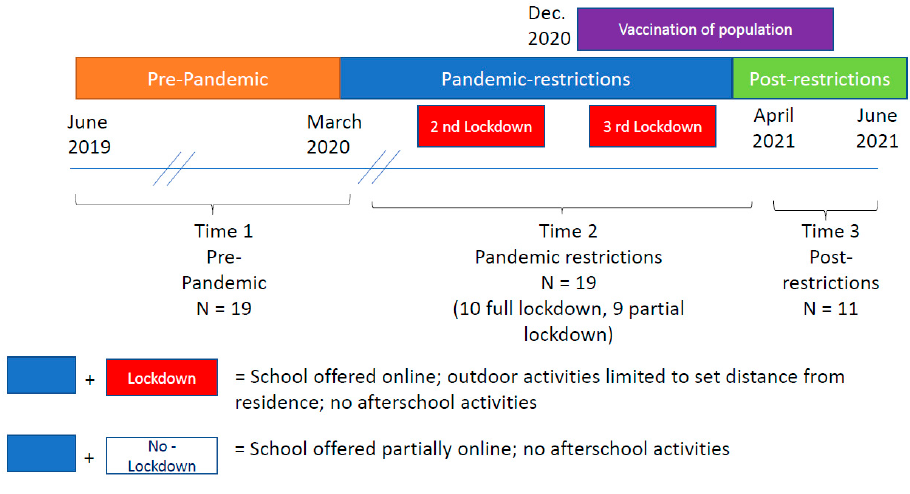
Figure 1. Timeline of Social Restrictions and Data